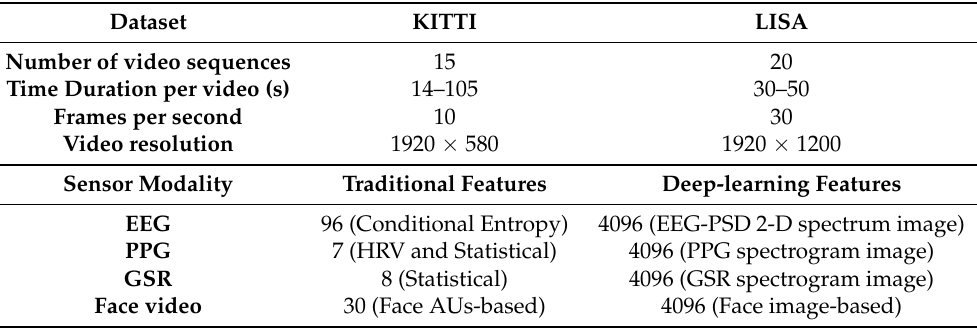
Table showing the various parameters pertaining to datasets and features used in